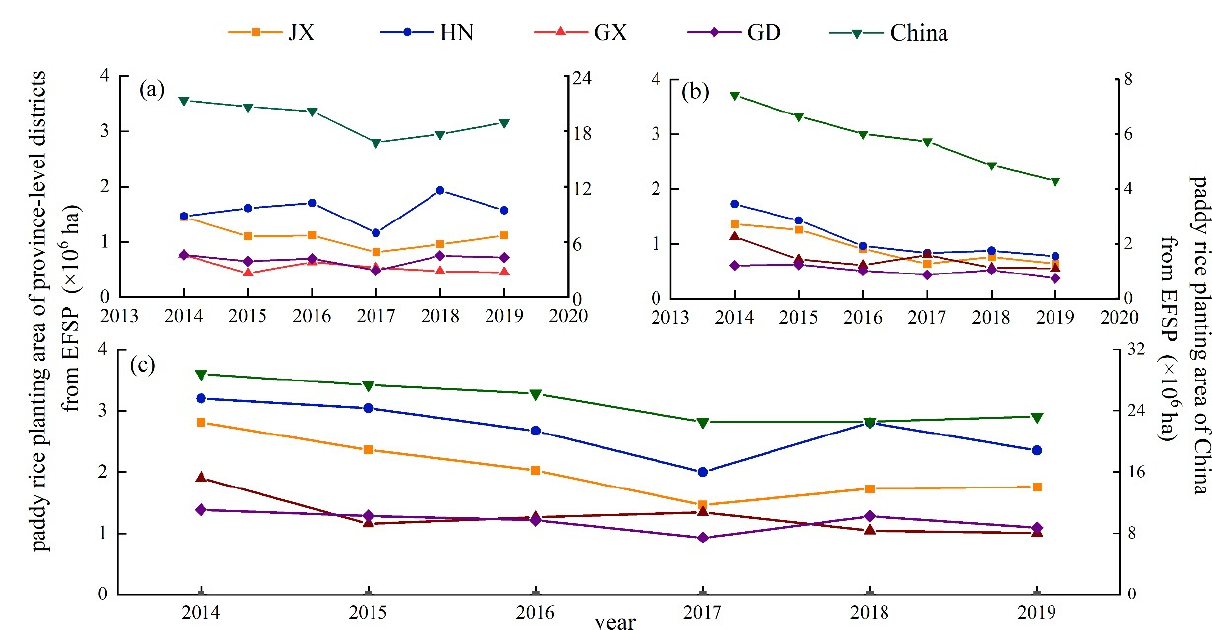
Figure 10. Variations in paddy rice planting area from EFSP rice in China and typical provinces from 2014 to 2019. ( a – c ) single paddy rice, double paddy rice, and total paddy rice planting area, respectively, from 2014 to 2019.